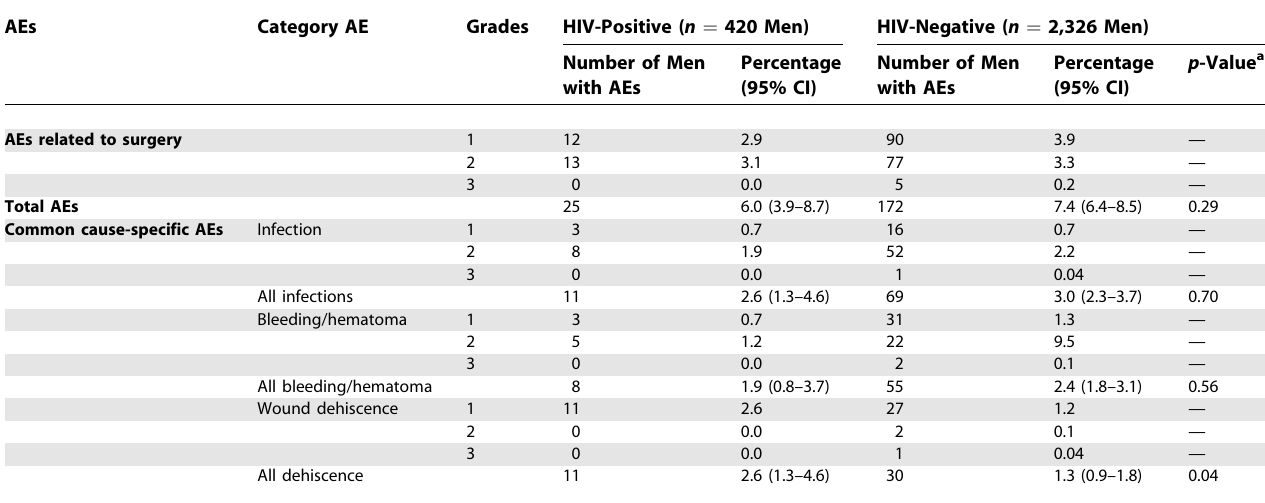
Table 2. Surgery-Related AEs by Severity